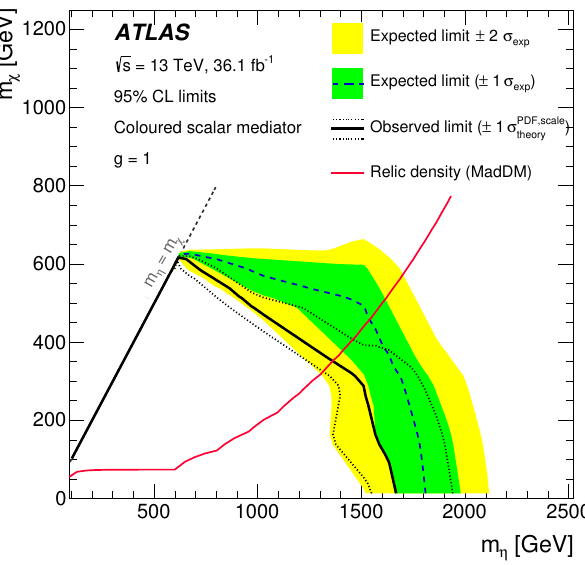
Figure 8 . Exclusion contours at 95% CL in the m (cid:17) { m (cid:31) parameter plane for the coloured scalar mediator model, with minimal width and coupling set to g = 1. The solid (dashed) curve shows the observed (expected) limit, while the bands indicate the (cid:6) 1 (cid:27) theory uncertainties in the observed limit and (cid:6) 1 (cid:27) and (cid:6) 2 (cid:27) ranges of the expected limit in the absence of a signal. The red curve corresponds to the expected relic density, as computed with MadDM [94]. The kinematic limit for the mediator on-shell production m (cid:17) = m (cid:31) , is indicated by the dotted line.